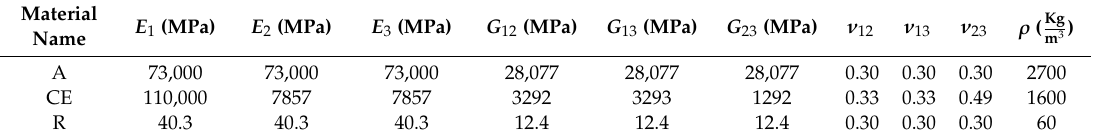
Table 2. Mechanical characteristics and material density of the unidirectional layers.